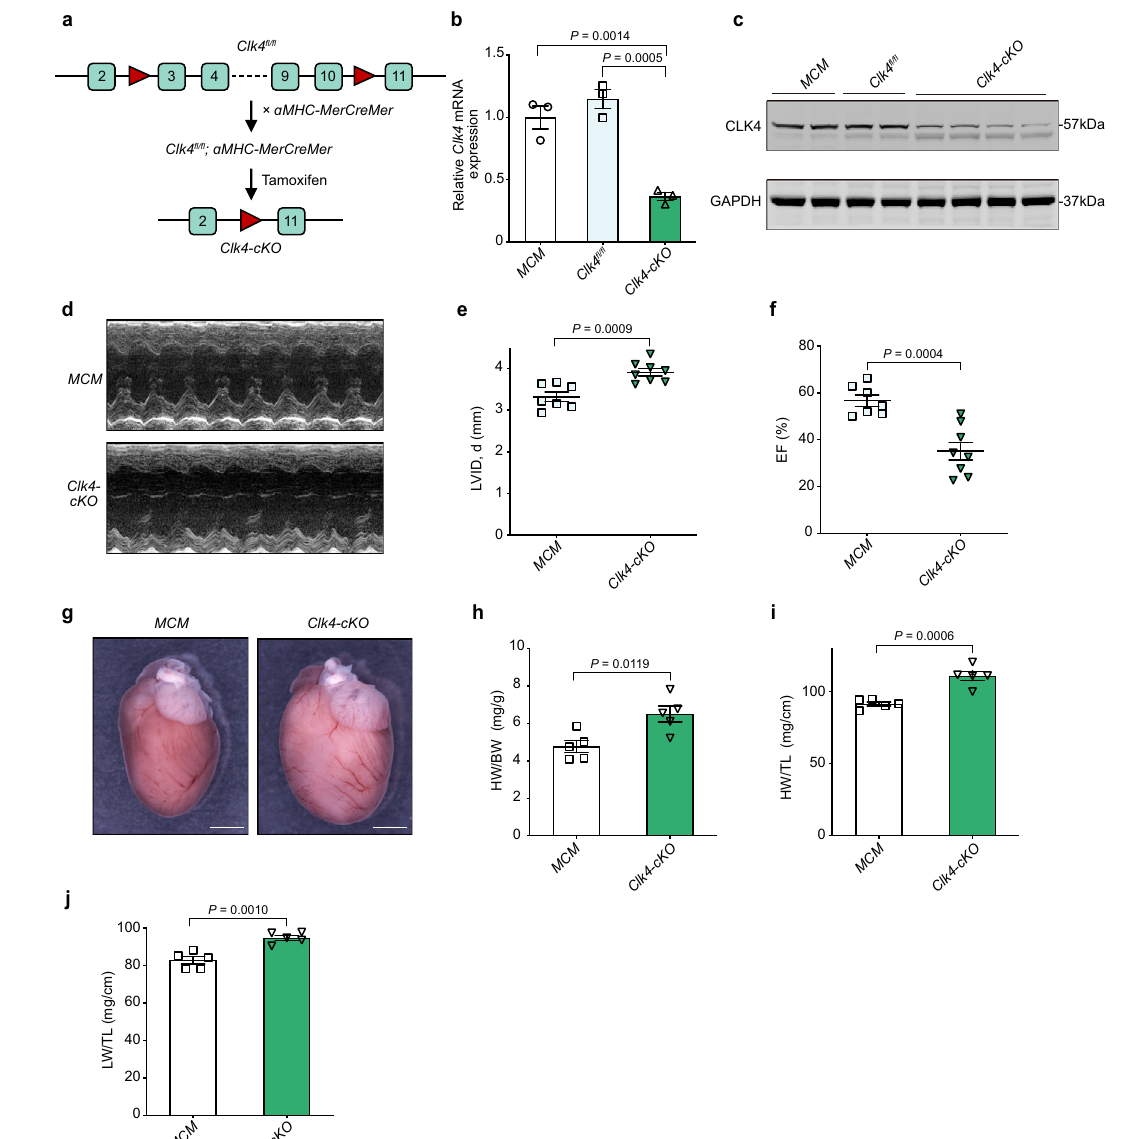
Fig.2|Cardiac-speci fi c Clk4 knockout( Clk4 -cKO)leadstocardiachypertrophy and dysfunction. a Schematic diagram of the gene targeting strategy. Clk4 exons 3 – 10 are fl anked by two loxP sites. Clk4 fl / fl mice were crossed with cardiomyocyte- restricted tamoxifen-inducible transgenic mice ( α MHC-MerCreMer, MCM) to generate Clk4 fl / fl × MCM mice. Then, tamoxifen was injected intraperitoneally to induce cardiomyocyte-speci fi c deletion in the adult heart ( Clk4 -cKO). b qPCR detectionof theexpressionof Clk4 mRNAin Clk4 -cKO andMCMlittermatecontrol hearts. Normalized to Gapdh expression. n =3 animals. c Western blot analysis of CLK4expressionin Clk4 -cKOhearts. d Representativeshort-axisM-modeimagesof MCM control and Clk4 -cKO left ventricles 3 weeks post tamoxifen initiation.